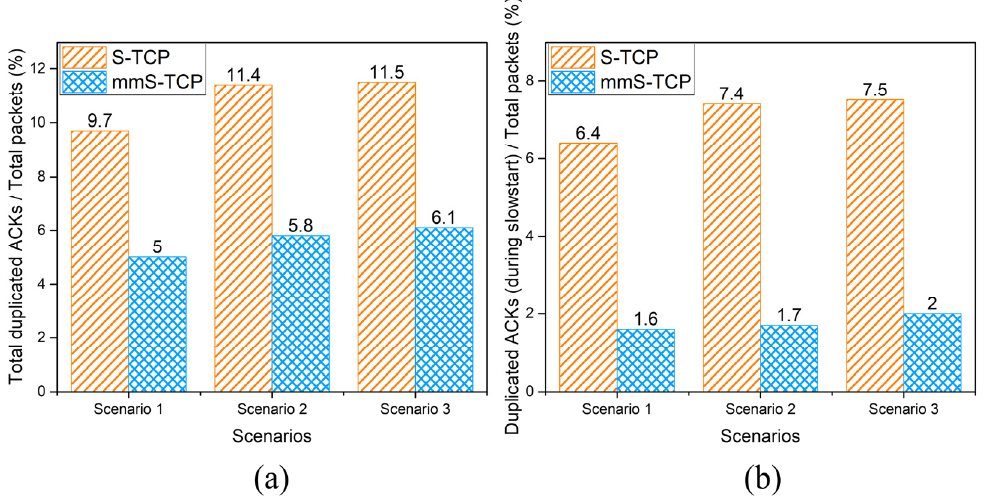
Figure 9. Comparisons of duplicated ACKs generated by S-TCP and mmS-TCP: ( a ) total duplicated ACKs/total packets; ( b ) duplicated ACKs during slowstart phase/total packets.